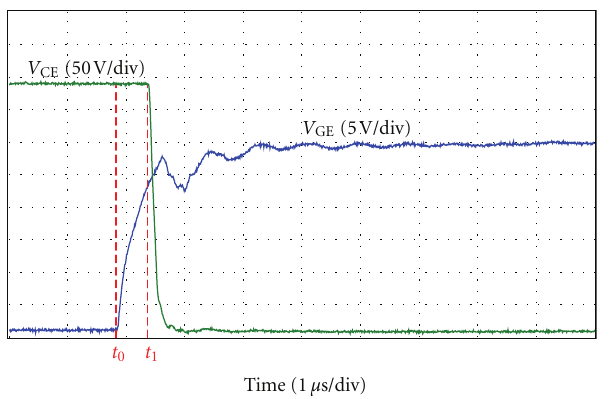
Figure 5: Turn-on waveforms of the IGBT module.